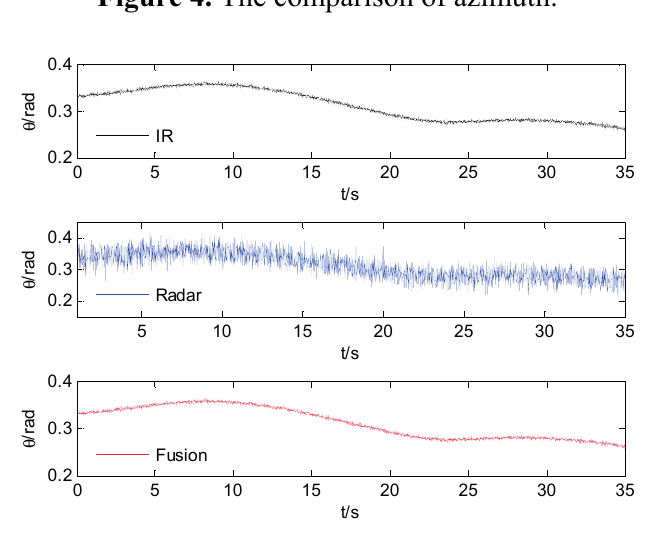
Figure 4. The comparison of azimuth.